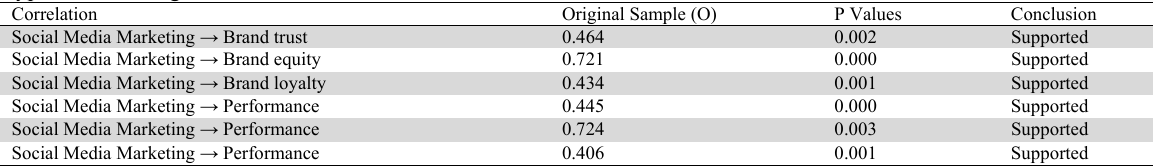
Hypothesis Testing Correlation